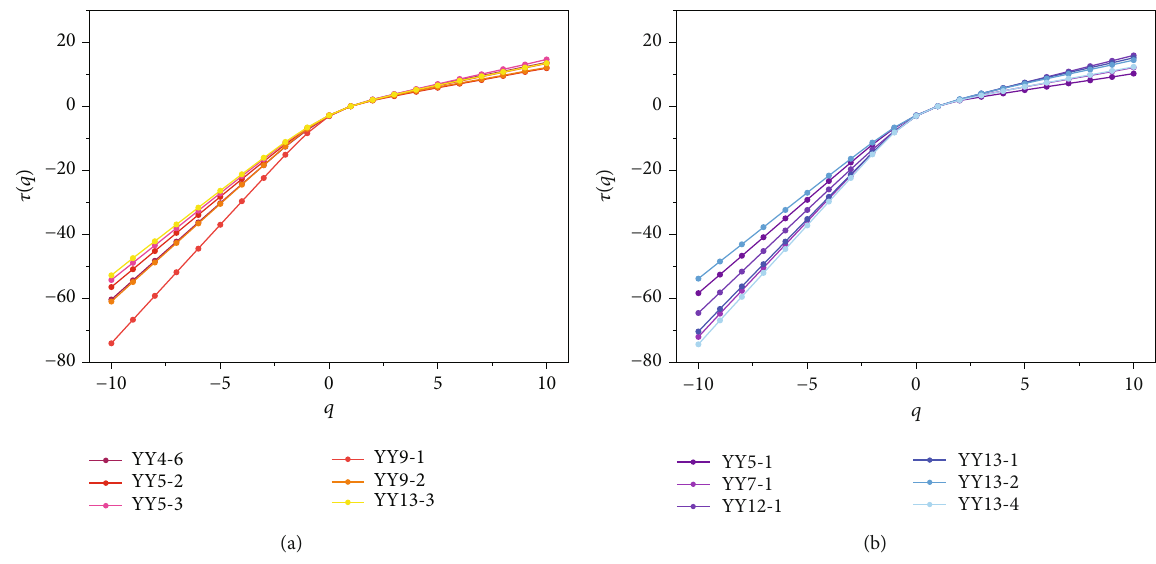
Figure 9: The relationship between the τ ð q Þ and q of Chang 7 shale from nitrogen adsorption. (a) SM lithofacies. (b) MS Table 4: Multifractal parameters of the SM and SM lithofacies calculated from low-pressure N